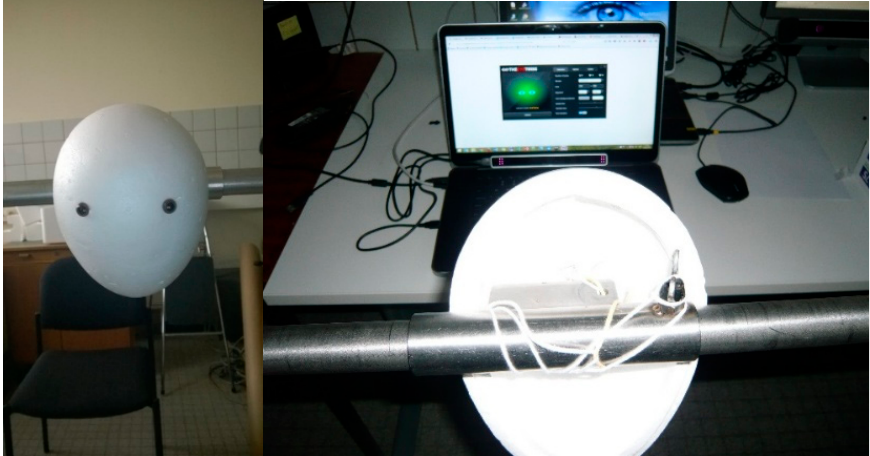
Figure 1. The artificial eyes and the stabilization mechanism.